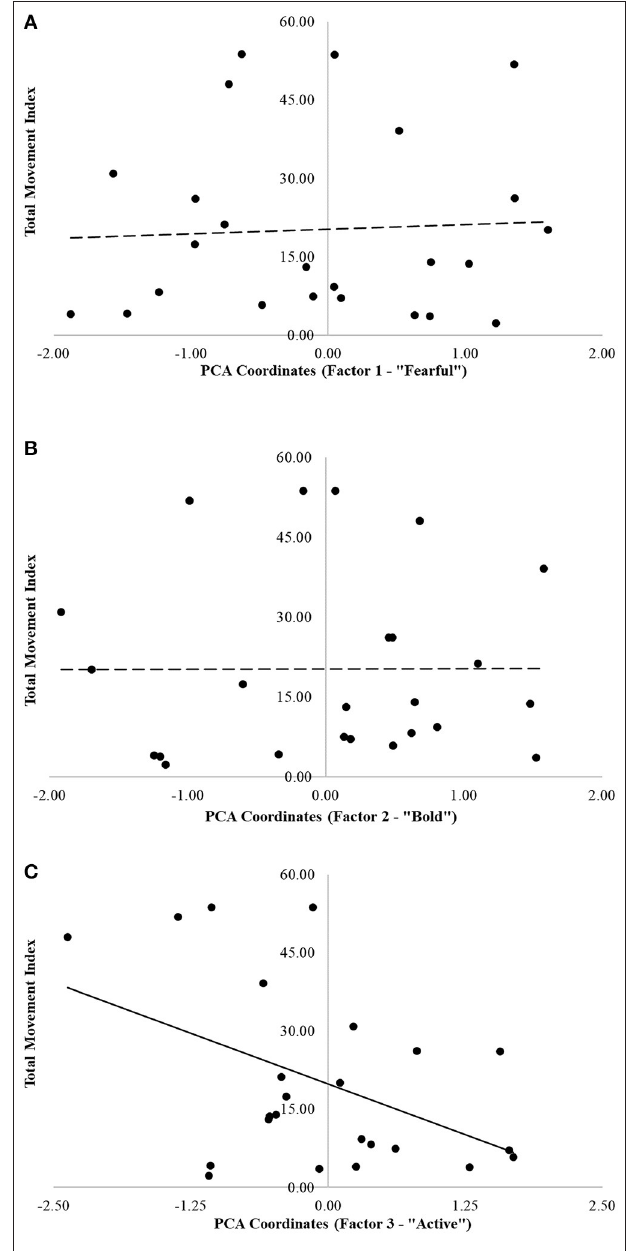
FIGURE 4 | (A–C) Distribution of individual calf total movement index from the isolation box test plotted against each factor of the principal component analysis of the traditional personality tests: (A) Factor 1 (“Fearful”), (B) Factor 2 (“Bold”), and (C) Factor 3 (“Active”). The linear regression trendline is presented for each plot (solid black line = significant regression, P < 0.05; dashed line = non-significant regression, P > 0.05).